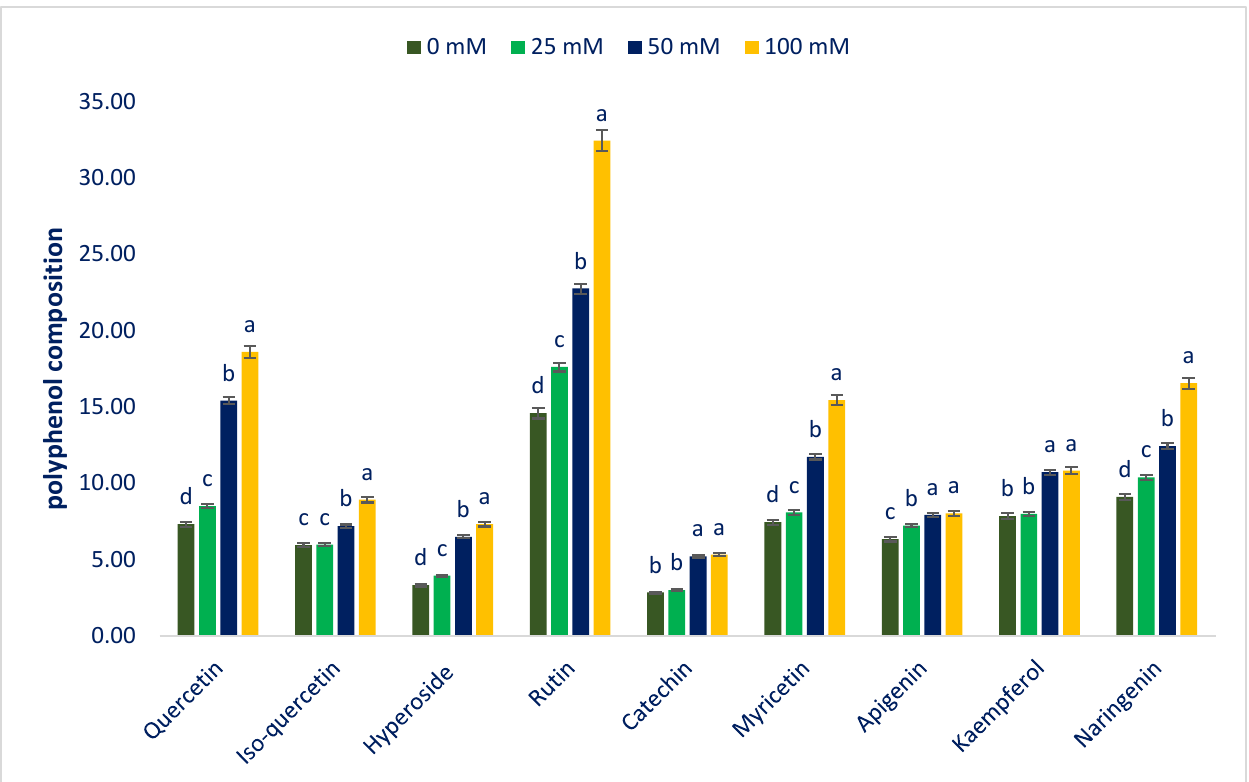
Figure 9. Impact on polyphenolic compounds of Lalshak under salt stress ( n = 6). Dissimilar letters in the bars varied significantly by DMRT ( p < 0.01).